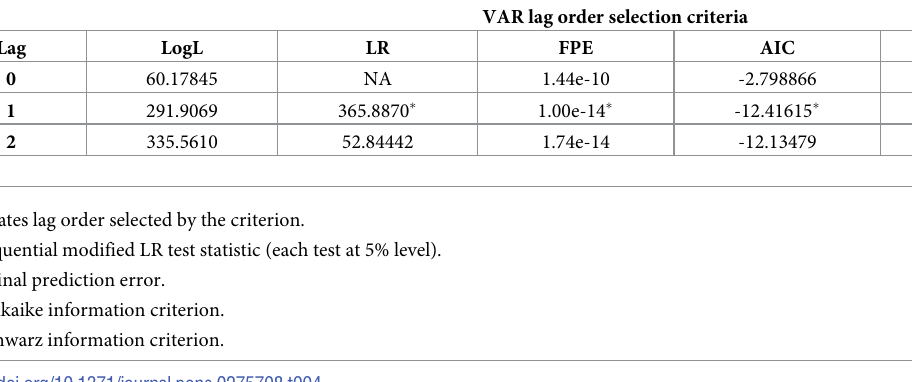
Table 4. Selection of optimal lag length.